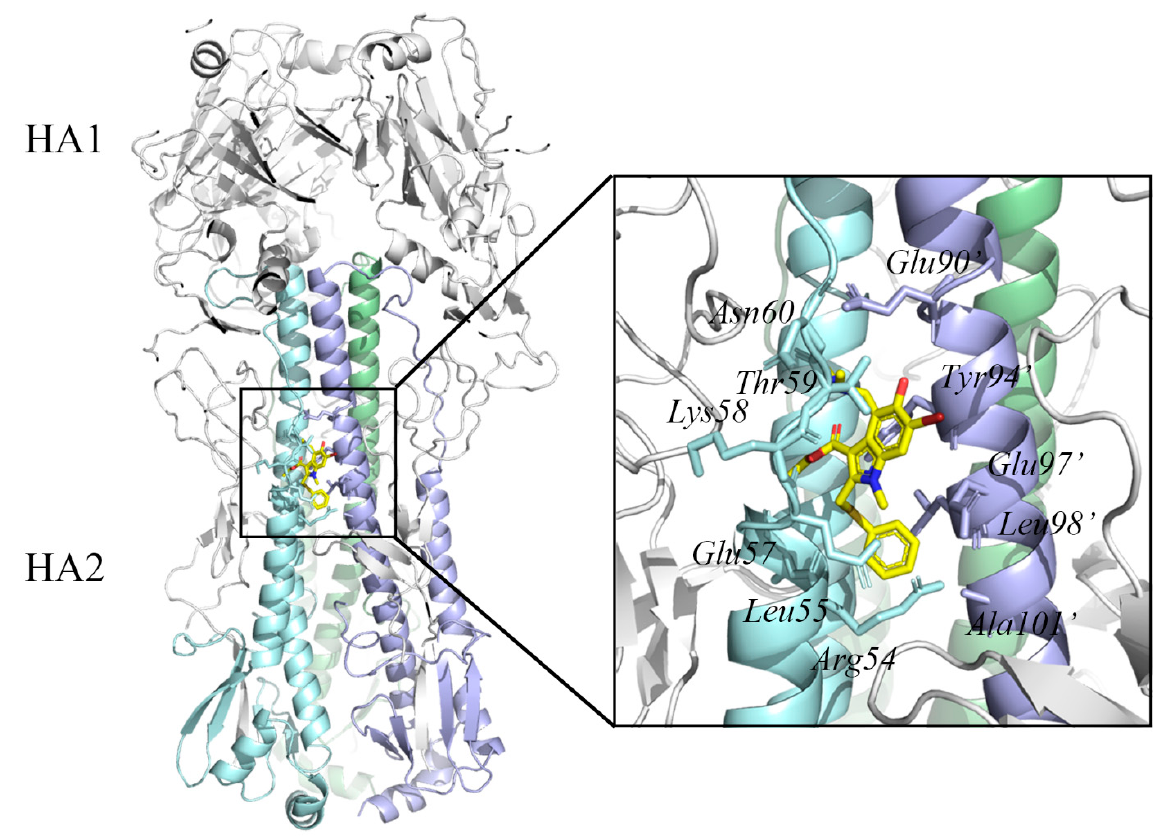
Figure 4. Structure of influenza A virus hemagglutinin in complex with the antiviral drug arbidol (PDB ID: 5T6S) [79]. The HA1 trimer molecules (head) are represented as a gray cartoon, and HA2 trimer molecules (stem) are represented as cyan, green, and blue cartoons, respectively. Arbidol is shown as yellow sticks. The residues in the arbidol binding site are indicated by sticks. The protein structure was displayed and analyzed through the PyMOL visualization program [69–71].